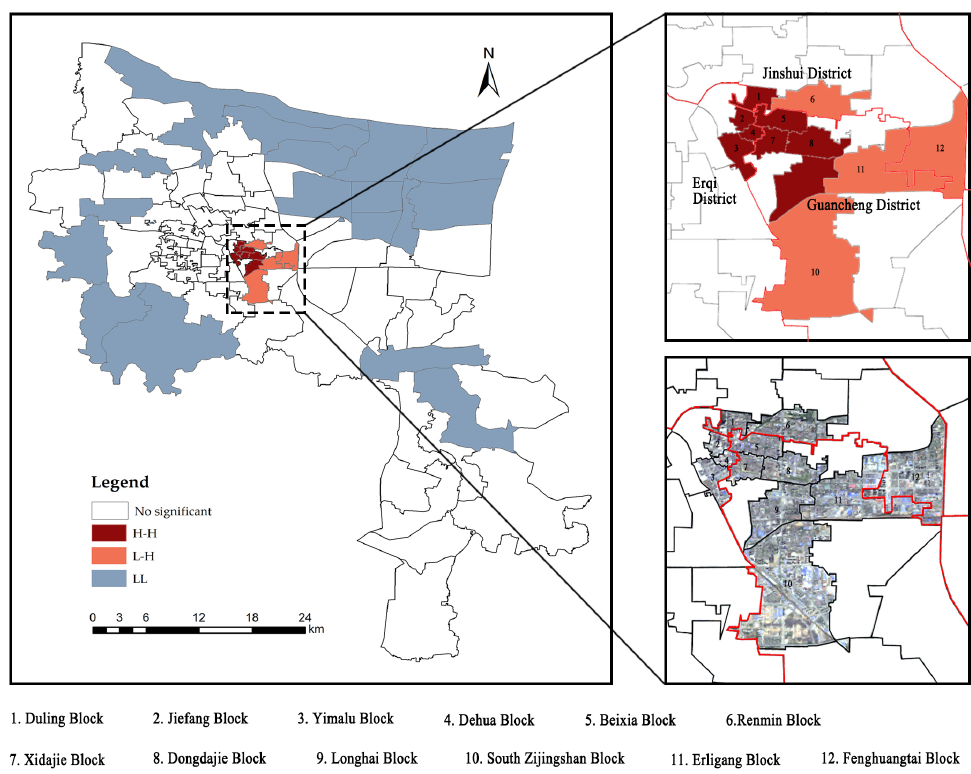
Figure 5. Local indicators of spatial association cluster map of population density and comprehensive excessive demand for ESs.